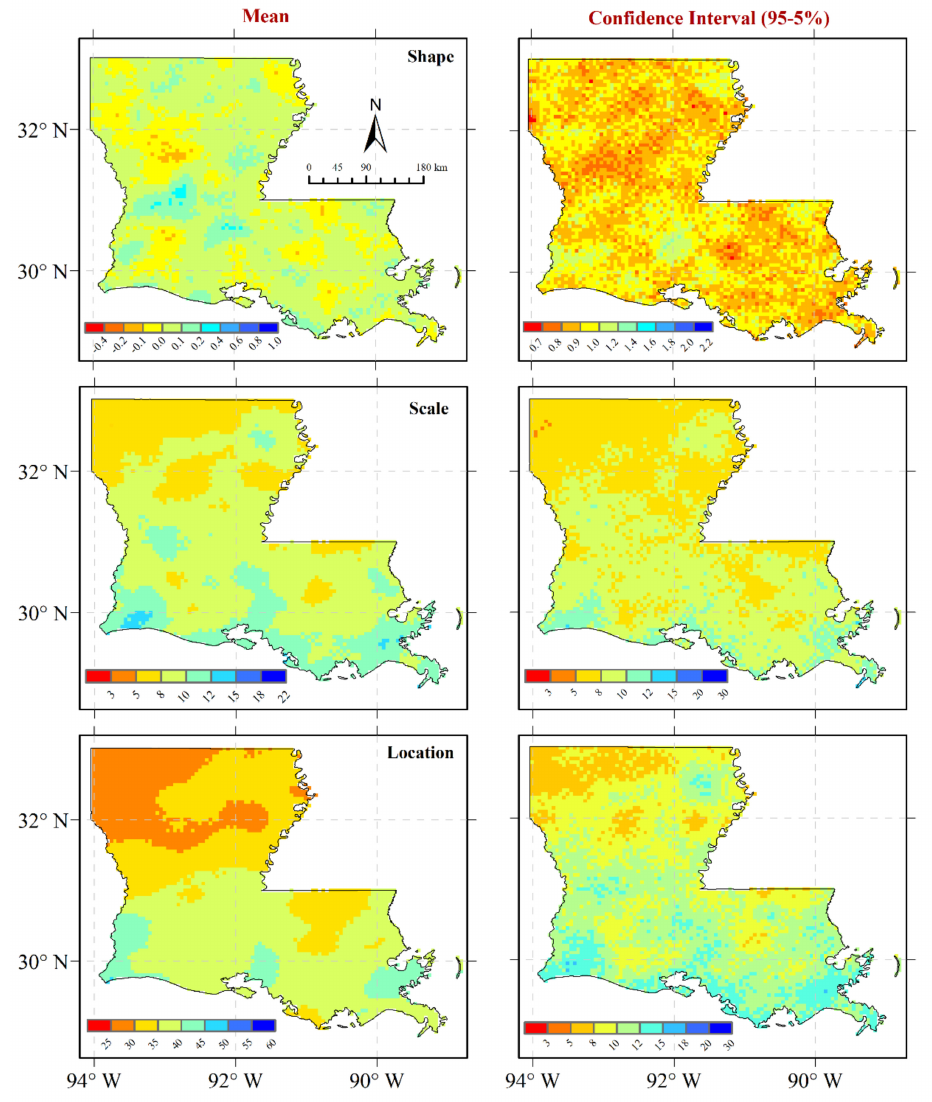
Figure 3. The GEV distribution parameters (shape, scale, and location parameters) from the spatial bootstrap (region-based) approach. Left Panels: Mean of 500 bootstrap runs. Right Panels: the confidence width (95–5%